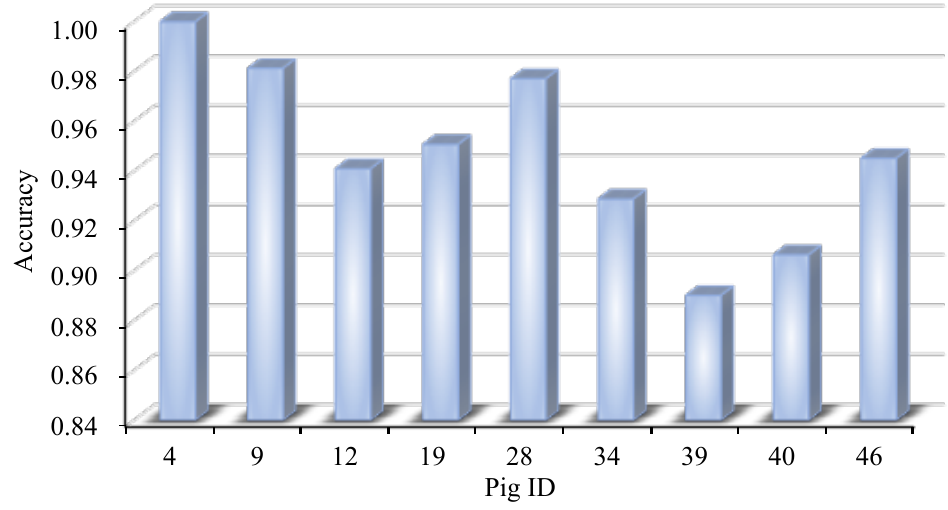
Figure 8. Accuracy at a fixed